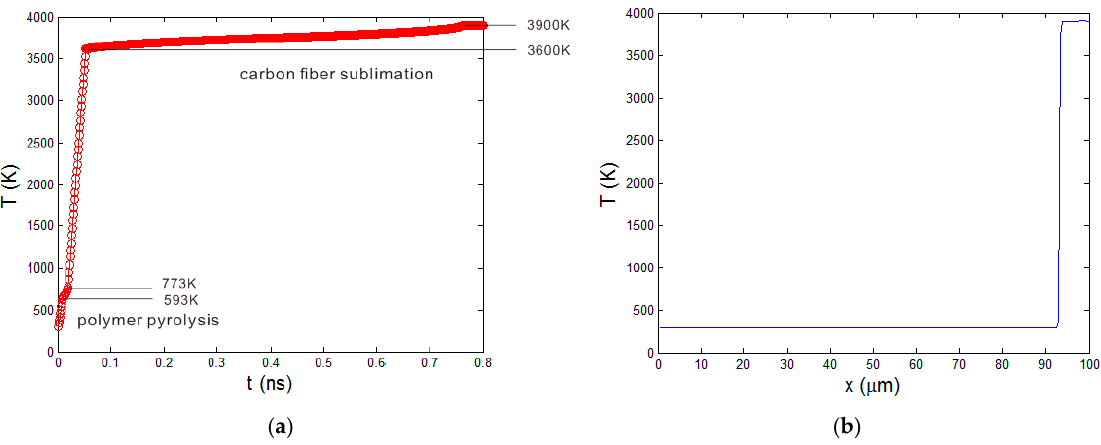
Figure 5. ( a ) Temperature curve at x = 100 μ m; ( b ) Temperature field at 10 ns.